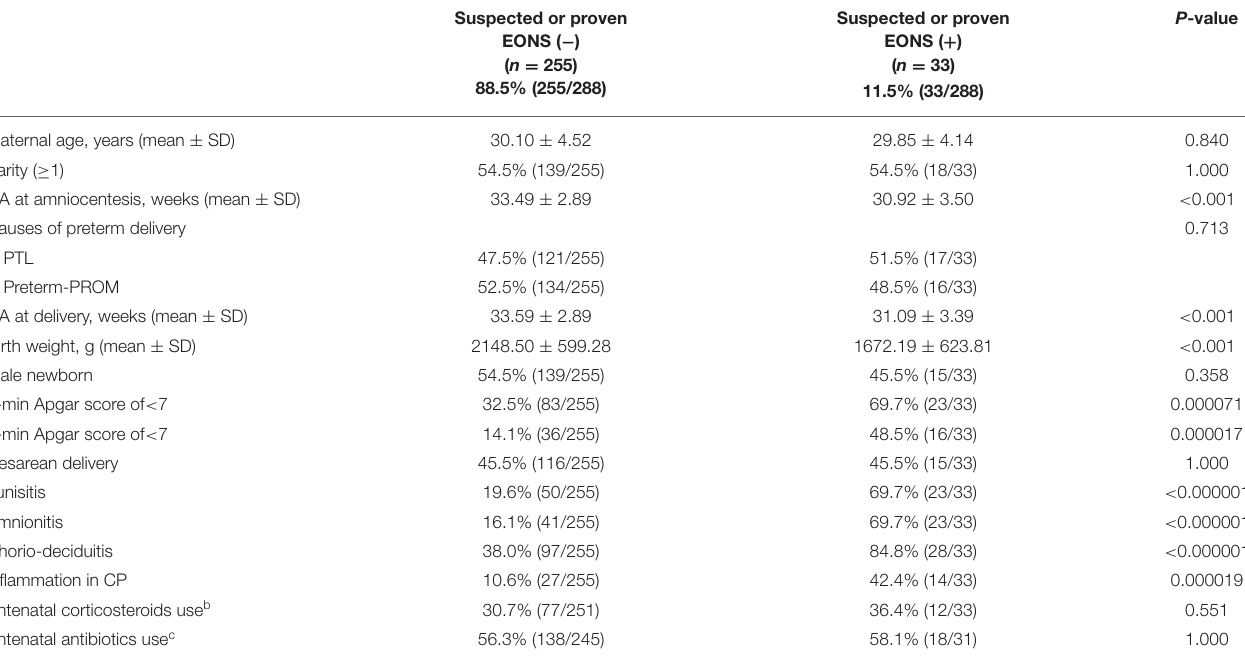
TABLE 4 | Clinical characteristics and pregnancy outcomes according to the presence or absence of suspected or proven early-onset neonatal sepsis (EONS) a